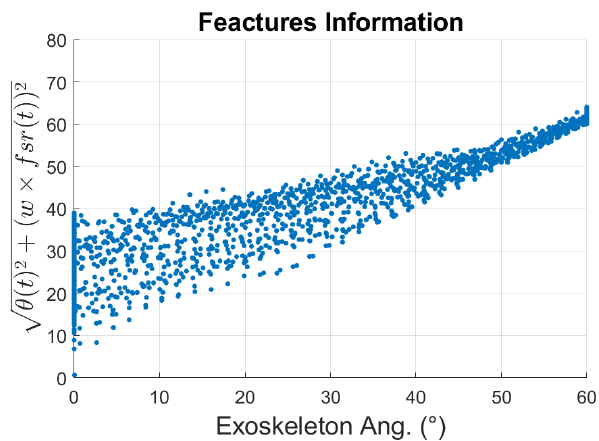
Figure 9. Scatter plot of the weighted L 2 - norm as the exoskeleton angles changed during elbow flexion–extension multiple